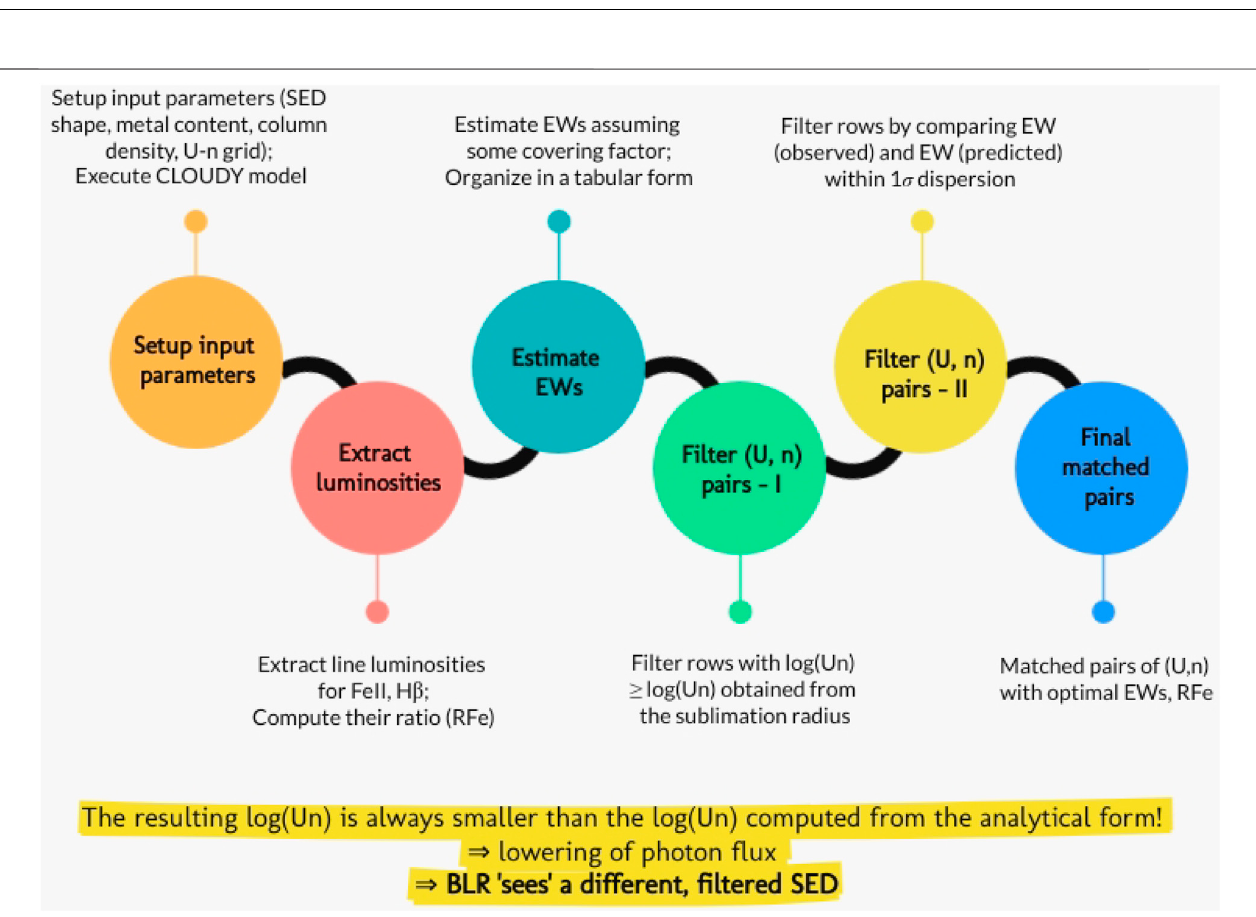
FIGURE9| Flowchartdepictingthestepstakeninthe fi lteringprocess — startingfromthepreparationoftheinputsetuptillprocuringthematchedpairsof(U,n H )for each model described in this article.